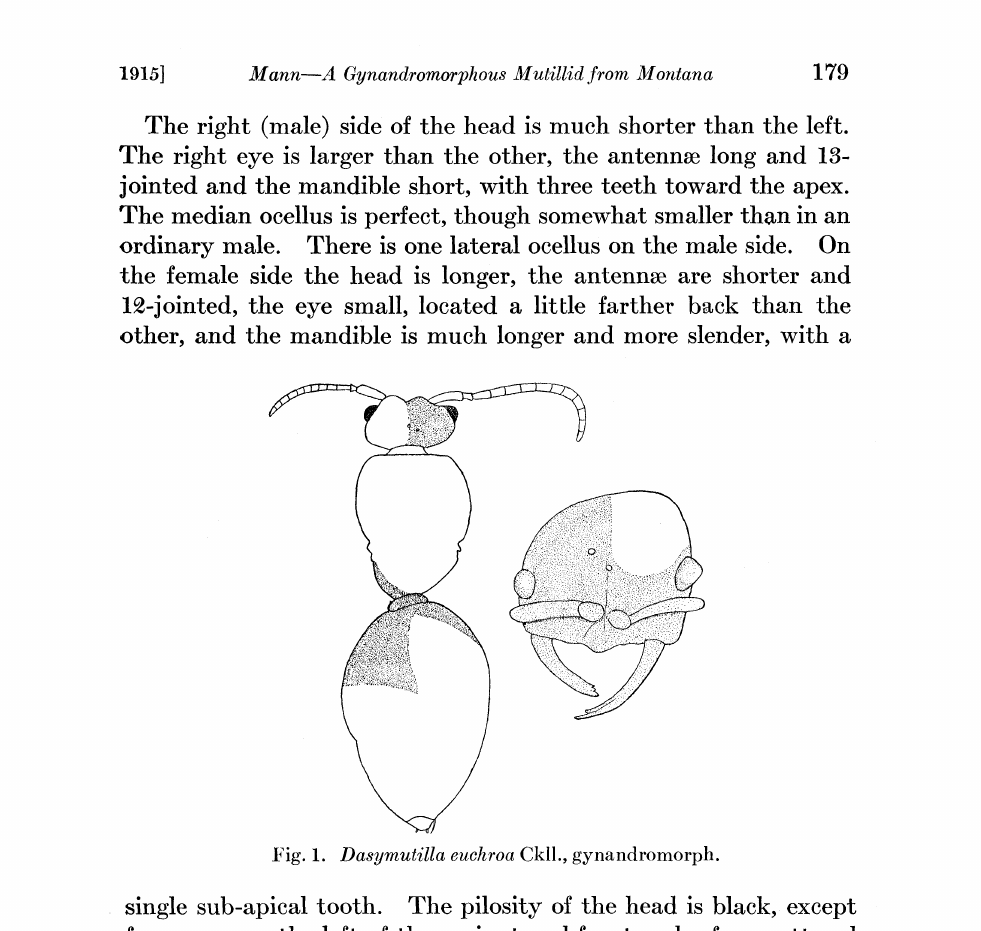
Fig. 1. Dasymutilla euchroa Ckll., gynandromorph. single sub-apical